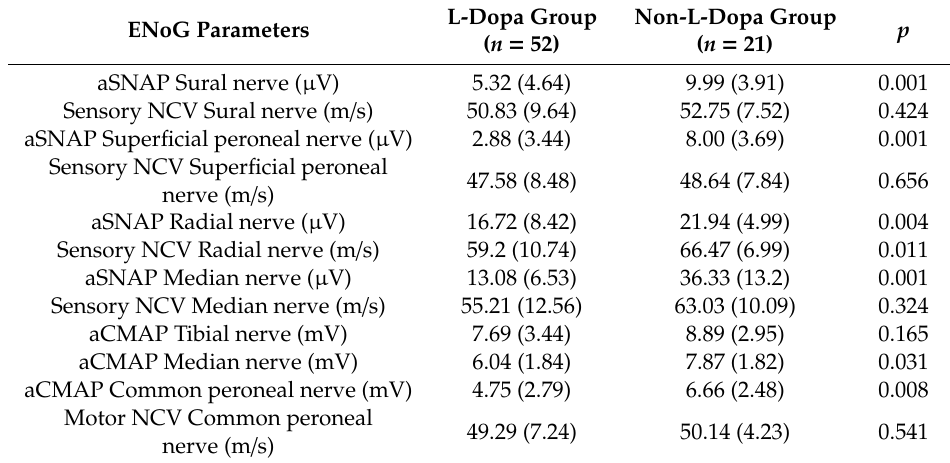
Table 2. Electrophysiological parameters in the two groups (independent samples t -test). Results are represented as mean (SD). ENoG, electroneurographic assessment; NCV, nerve conduction